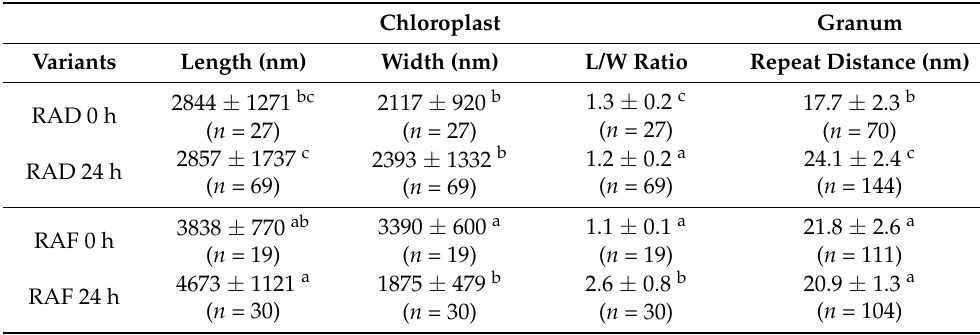
Figure 1. Cell ultrastructure during recovery from drought-induced desiccation (RAD) of Haberlea rhodopensis leaves. ( A ): 0 h, ( B ): 9 h, ( C ): 15 h, ( D ): 18 h, ( E ): 24 h, ( F ): 30 h after rehydration. Arrowhead: plasma membrane; asterisk: plastid; Cw: cell wall; V: vacuole. Scale bar is equal to 10 µ m. Table 1. Chloroplast ultrastructural features of H. rhodopensis during the recovery from drought- (RAD) and freezing-induced desiccation (RAF) as measured on TEM micrographs. Statistically significant differences among different samples ( n is indicated for all groups) are indicated with different letters ( p ≤ 0.05) within the different